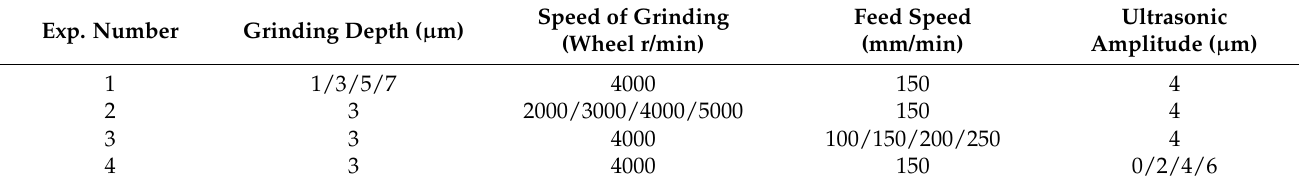
Table 5. Longitudinal-torsional ultrasonic single-factor grinding parameters of TC4 titanium alloy. Exp.